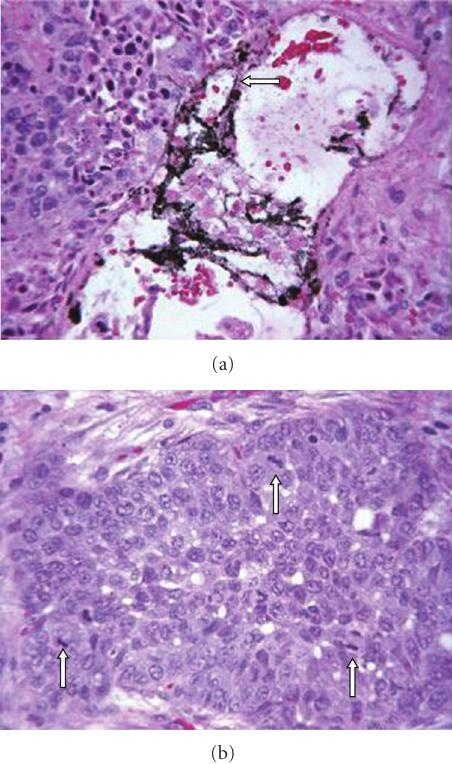
Figure 5: Photomicrographs of hepatic VX2 tumors from rabbits that received (a) or did not receive (b) intratumoral injection of Kentera single-walled carbon nanotubes (SWNTs) followed by 2 minutes of RF field treatment. SWNTs (arrow) can be identified surrounded by necrotic tumor. (Routine H & E stain,magnification, x400). Reproduced with permission from Cancer, vol. 110, no. 12, pp. 2654–2665,